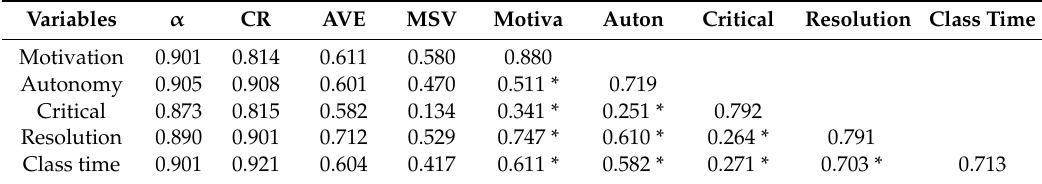
Table 2. Reliability and validity indices for the attitudinal factor.